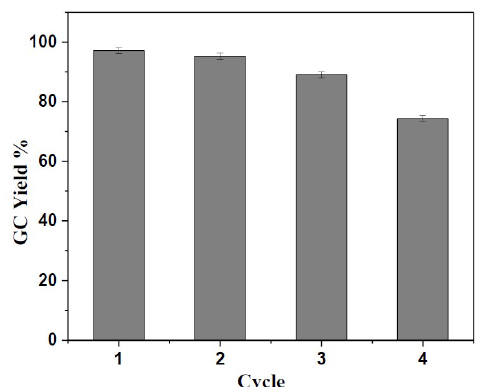
Figure 6. PL spectra of T and DT samples.